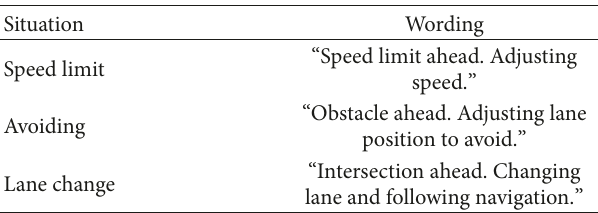
“Speed limit ahead. Adjusting speed.” “Obstacle ahead. Adjusting